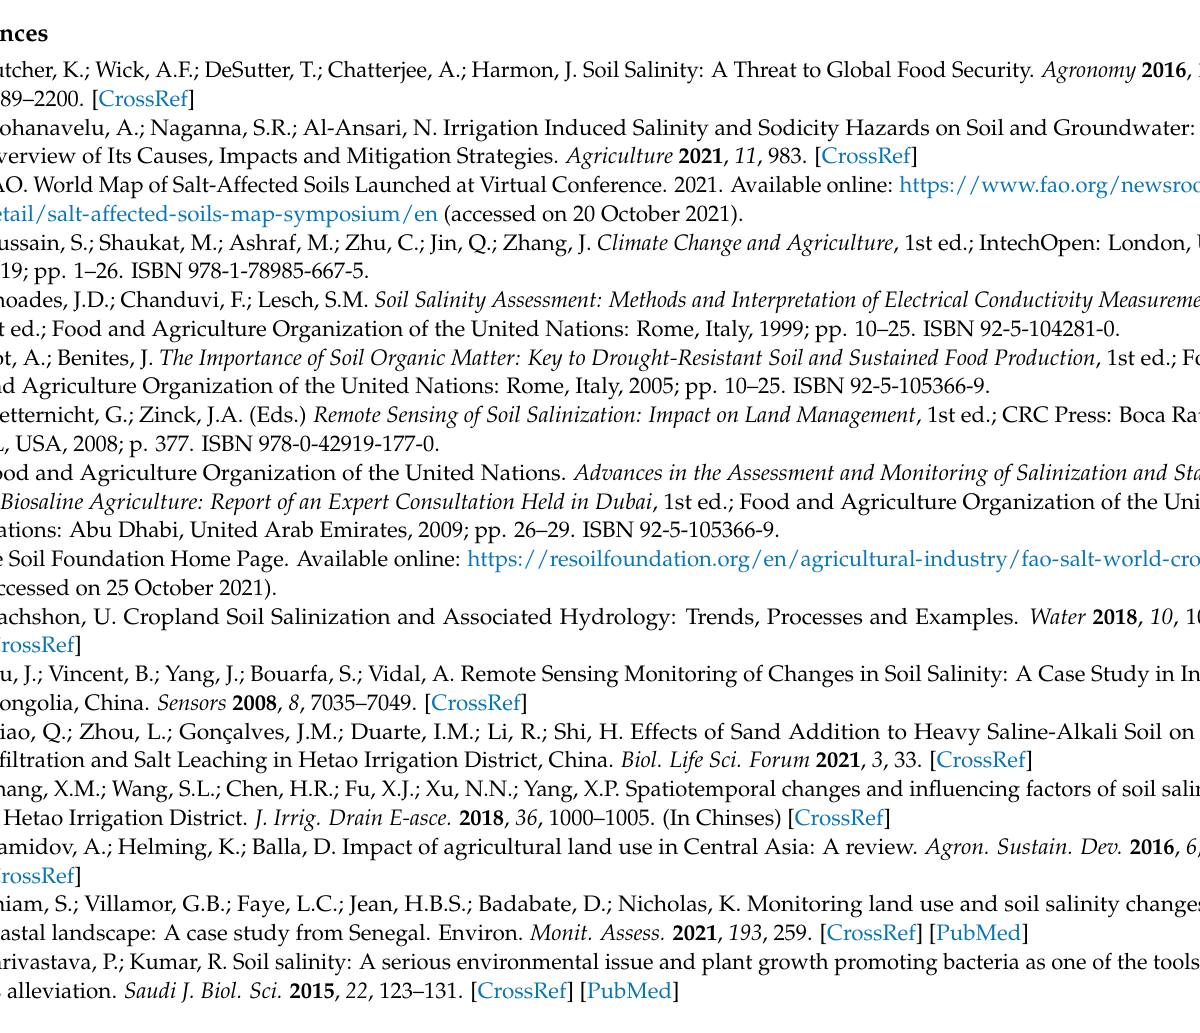
Figure A2. Results of the box plot accuracy assessment for several dataset combinations in the dry and wet seasons. The dry season in HID is represented by Mar and Mar to Apr on the x-axis, whereas the wet season in HID is represented by Aug and Aug to Sep on the x-axis.